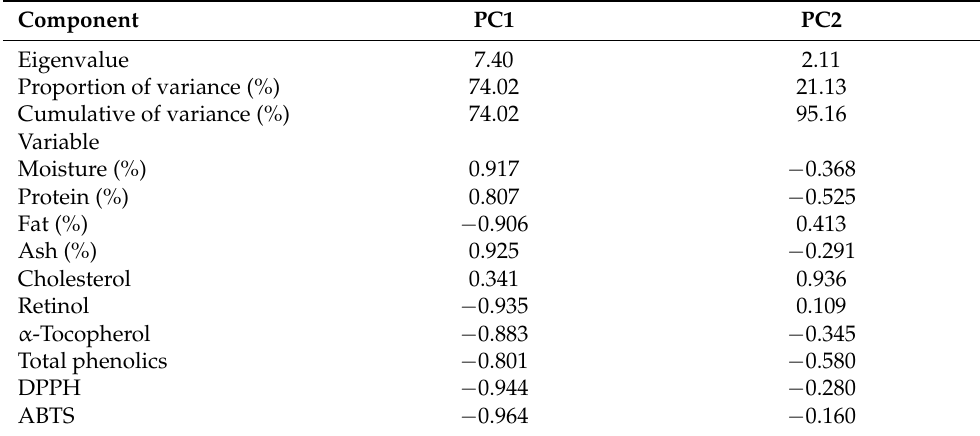
Table 4. Eigenvalues, the proportion of variation (%), and correlations between the principal compo- nents and the original